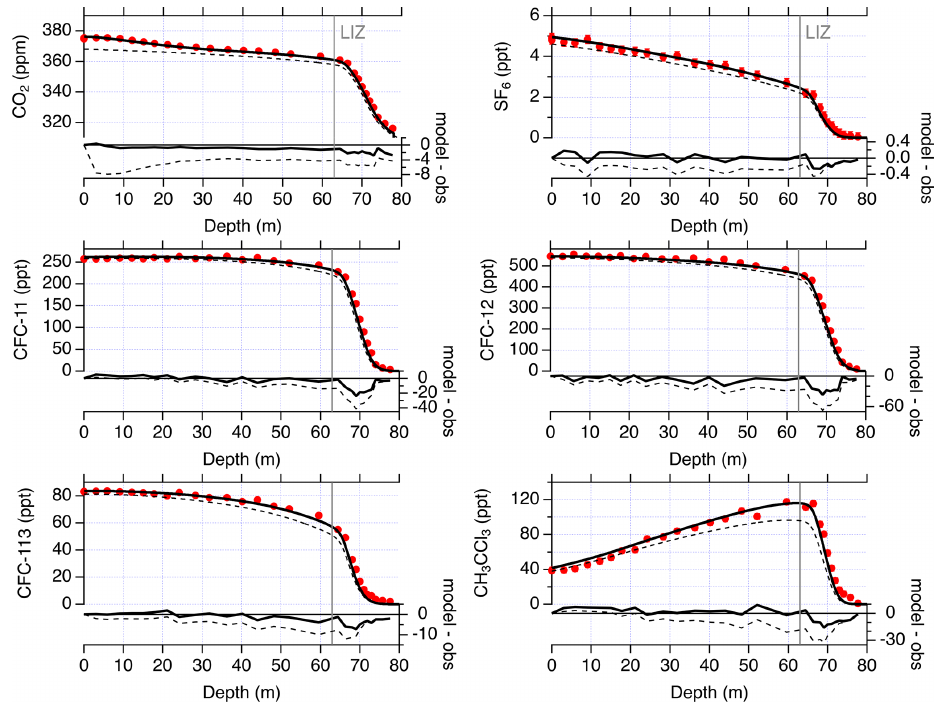
Figure 5. Depth profiles of CO 2 , SF 6 , CFC-11, CFC-12, CFC-113, and CH 3 CCl 3 in the NGRIP firn. The measurement and model results are shown by red circles and black solid lines, respectively (left axis). The measurement uncertainties are shown as vertical error bars, though in many cases they are smaller than the circle sizes. Black solid lines show the modelled profiles with the initial diffusivity and the BZ scenarios. The black dashed lines indicate the profiles calculated with the atmospheric scenarios for Antarctica (red lines in Fig. 2). The model–data differences are also shown (right axis). The vertical solid line in each panel indicates the upper depth of LIZ.